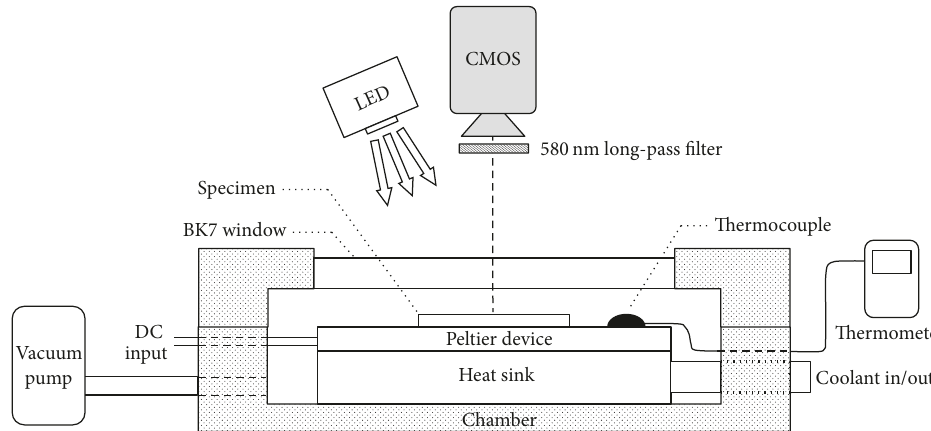
Figure 6: Calibration chamber of temperature sensitive paint.